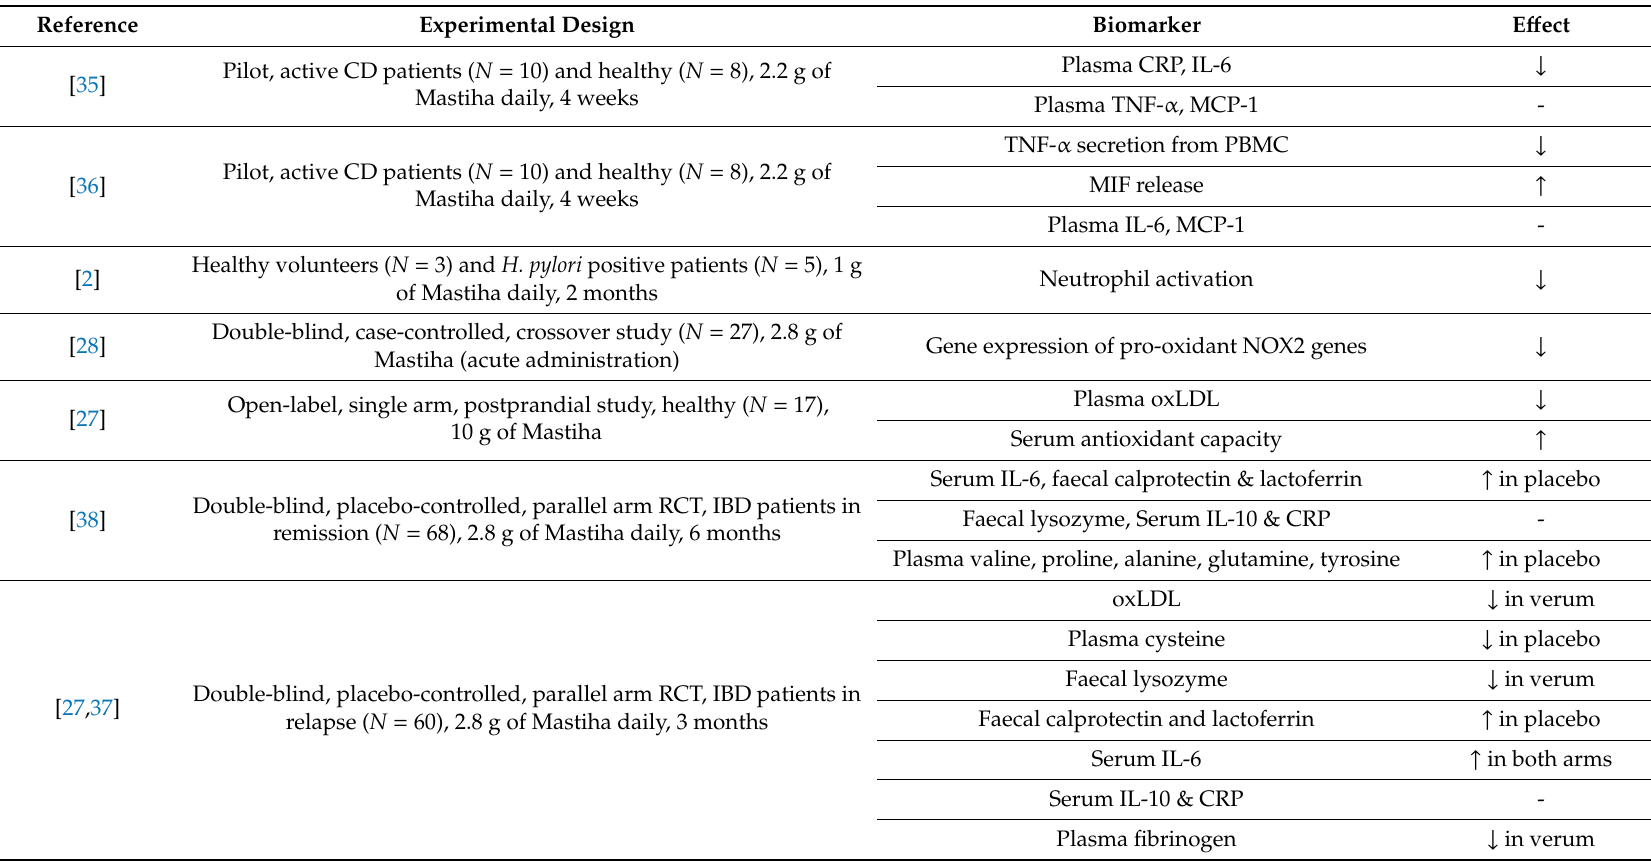
Table 2. Clinical evidence of the antioxidant and anti-inflammatory e ff ects of